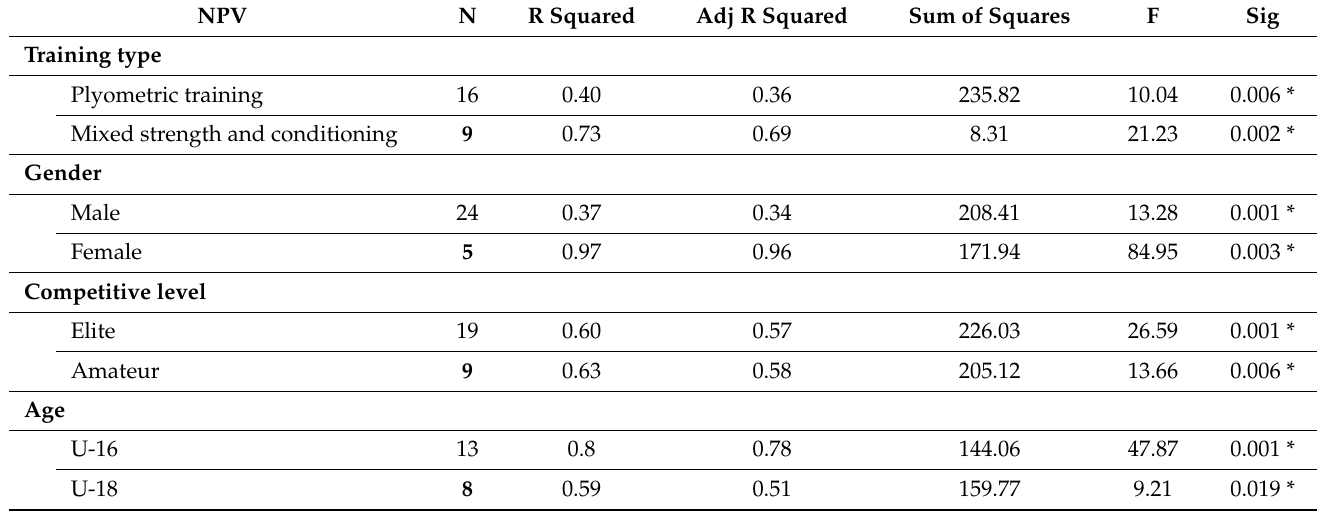
Table 4. Meta-regression statistical analysis for neuromuscular power vertical (NPV) according to sub-groups. In bold, models that did not reach the minimum 10 studies for meta-regression analysis.